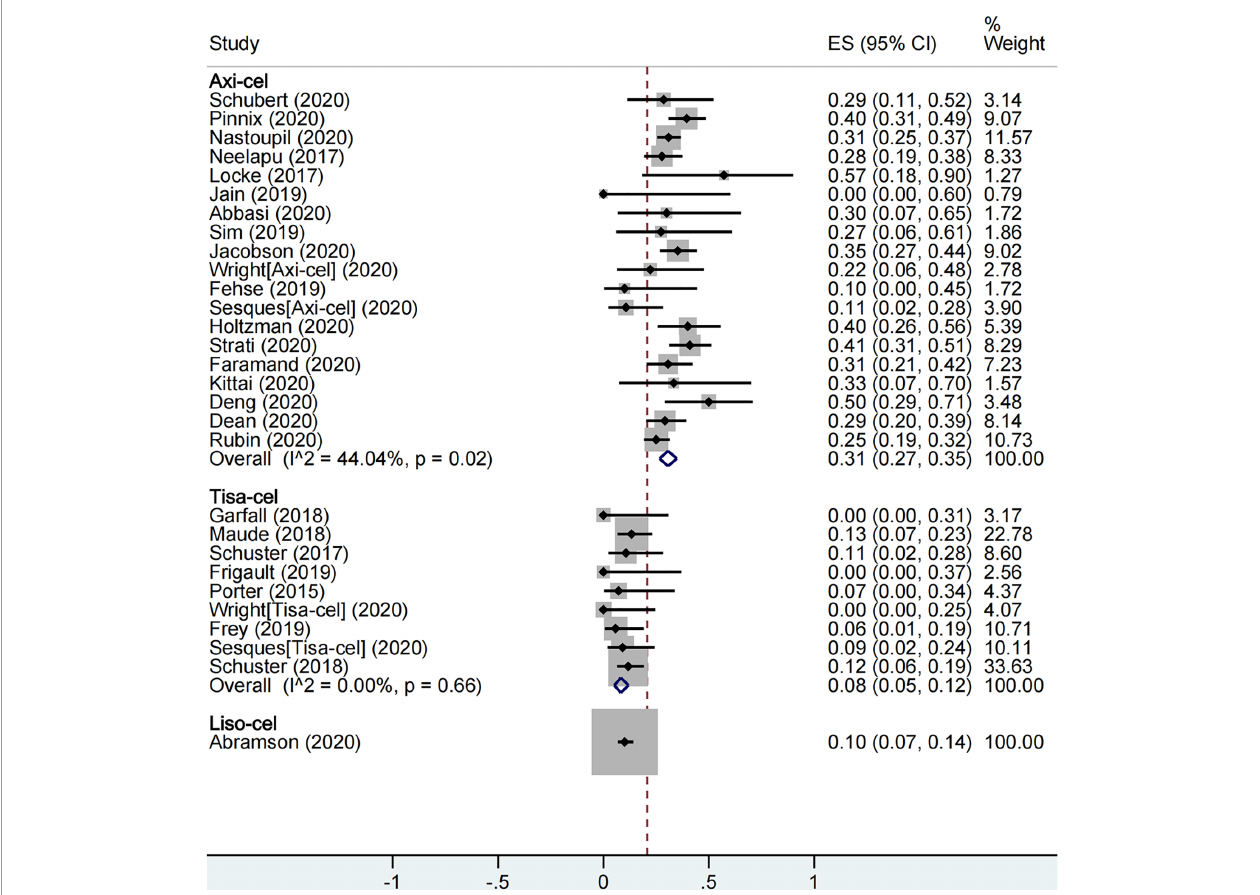
FIGURE 5 | The forest plot of total severe immune effector cell-associated neurotoxicity syndrome rate of each product.